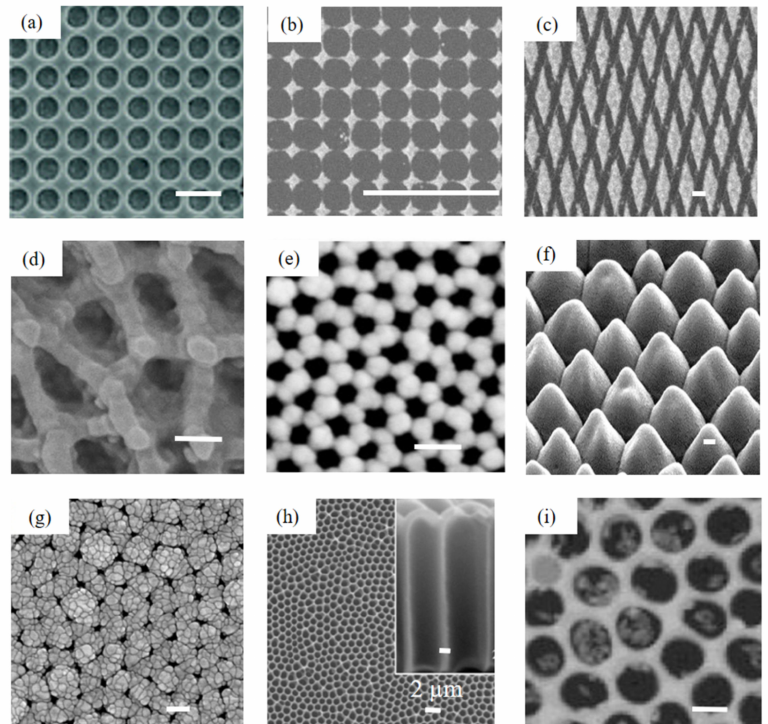
Figure 4. TEM and SEM images of top down approaches including E-beam fabricated ( a ) gold nanodisks [104], ( b ) Au star-like arrays [112], ( c ) Au diamond shaped structures [112], ( d ) Au dimple structures on PEN films treated by ion beam irradiation [113], ( e ) Au NPs distributed on the nanotips of canonical nanopores rims [114]; AAO templated structures: ( f ) Au nanostructure arrays [115], ( g ) Nano-flower like Ag/AAO [116], ( h ) Au nano-island @ Ag-frustum arrays [117], and ( i ) Au nanobipyramids self-assembled onto the AAO substrate [118]. Scale bars are all 100 nm without further indication in